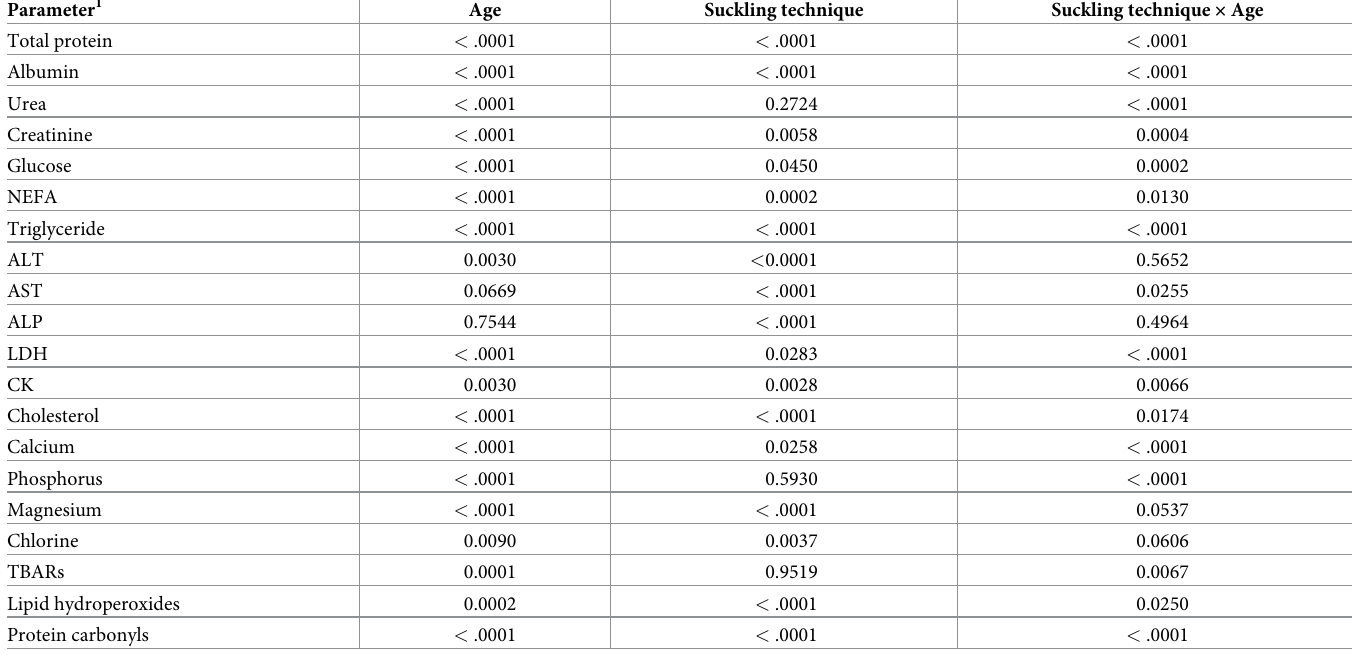
Table 1. Analysis of